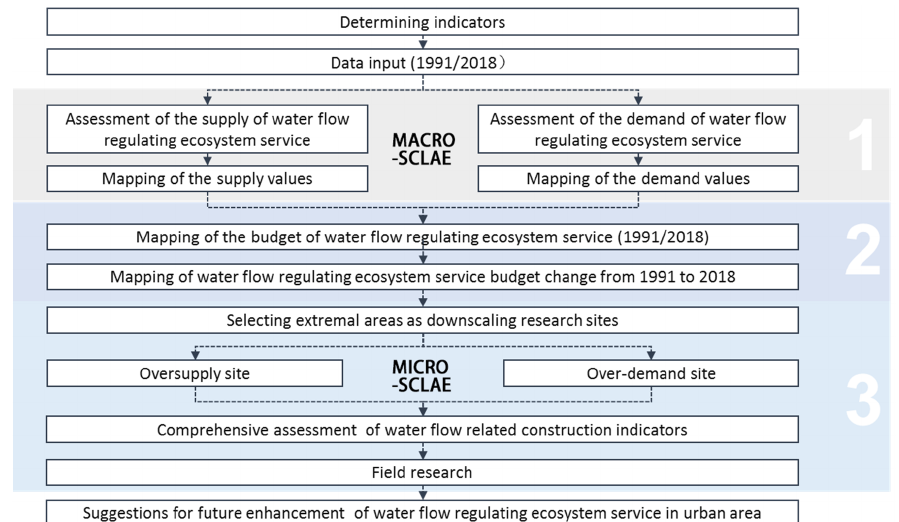
Figure 5. The method used in the assessment and mapping of water-flow-regulating ESs. 1: Mapping of the supply and demand of water-flow-regulating ESs. 2: Mapping of the budget of water regulating ES. 3: Downscaling research and field research on selected research sites.